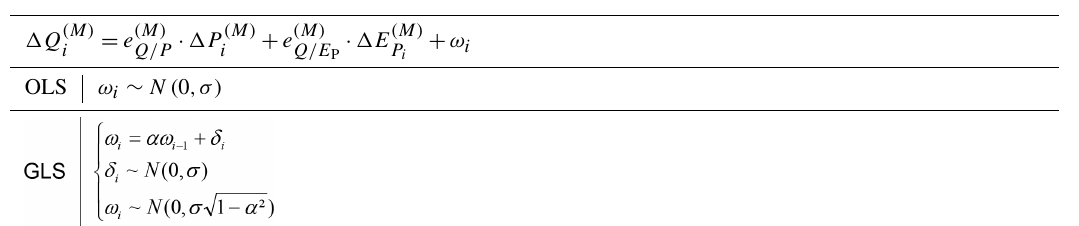
Table 5. Bivariate regression models for empirical elasticity